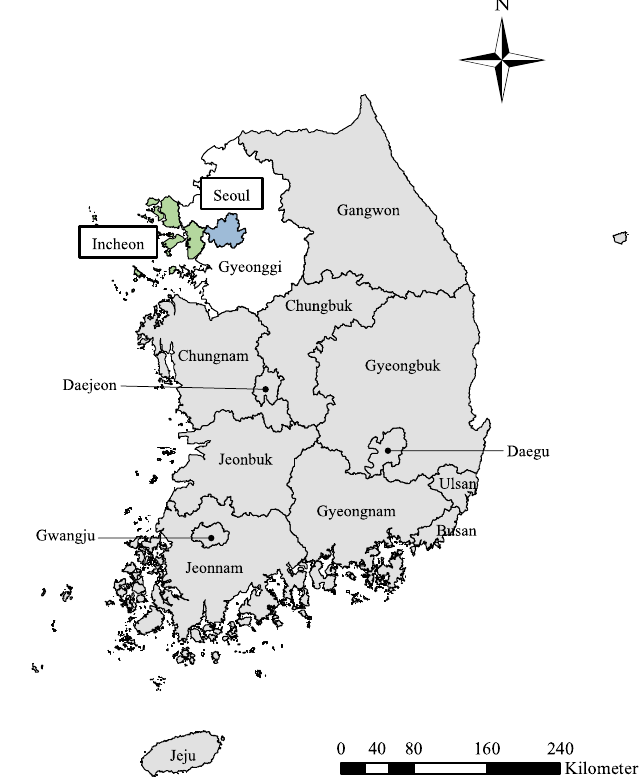
Figure 1. Map of cities and provinces in South Korea (colored regions—the intervention groups; gray regions—the potential control groups; Seoul metropolitan area—Seoul, Incheon and Gyeonggi).